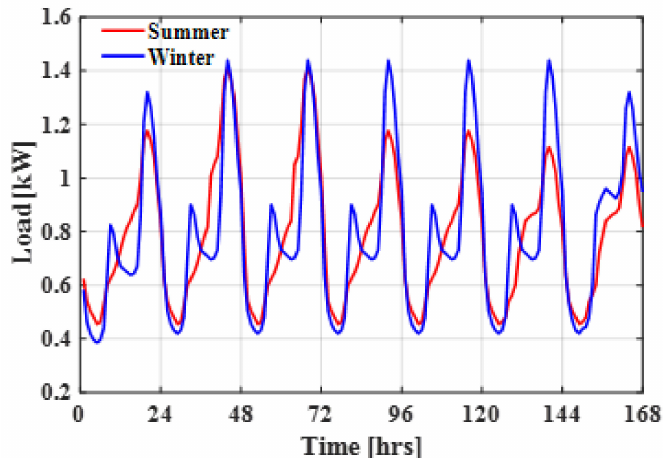
Figure 6. Load profile of a typical house in SA for a week in summer and a week in winter.